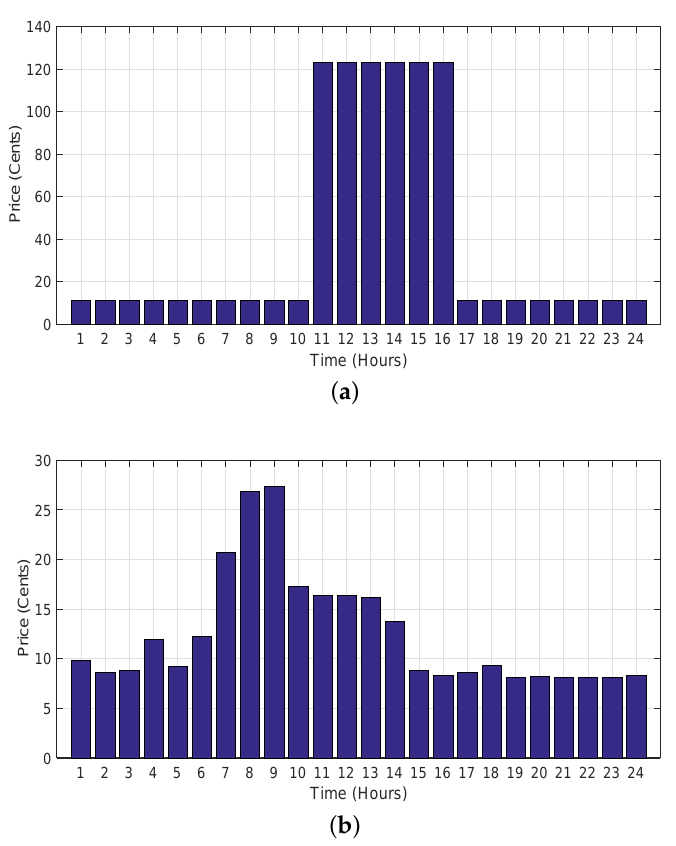
Figure 2. Pricing tariff. ( a ) Critical peak pricing.; ( b ) Real time